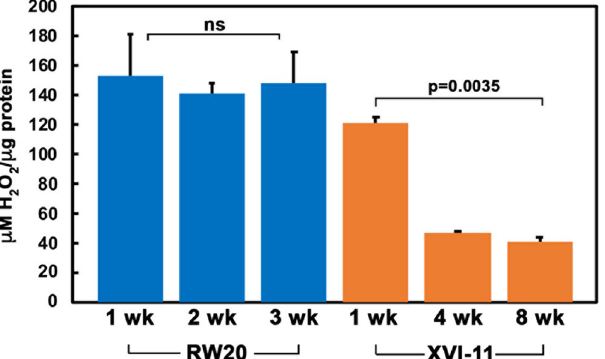
Figure 6. Comparison of hydrogen peroxide levels in short-lived RW20 and long-lived XVI-11. Hydrogen peroxide levels were determined at the indicated ages for short-lived RW20 and using a kit available through Pierce. Before the kit, which uses a colorimetric assay, was used with samples from aged Daphnia , the kit was standardized for use with Daphnia samples (Data not shown). All reactions were performed in a 96 well plate that was read on a BioTek Plate reader at a wavelength of 560 nm using the Gen5 software that was included as part of the Bio-Tek plate reader. Blue corresponds to short-lived RW20 and orange corresponds to the long-lived XVI-11. Error bars indicate the standard error of the mean from 3 experiments. Student T-tests were performed and the p values are as indicated, ns means not significant.